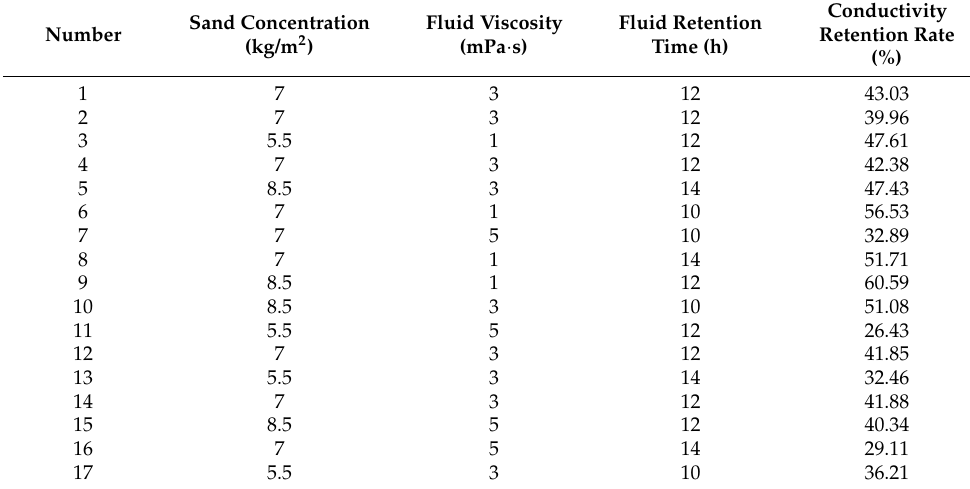
Table 2. Results of the response surface